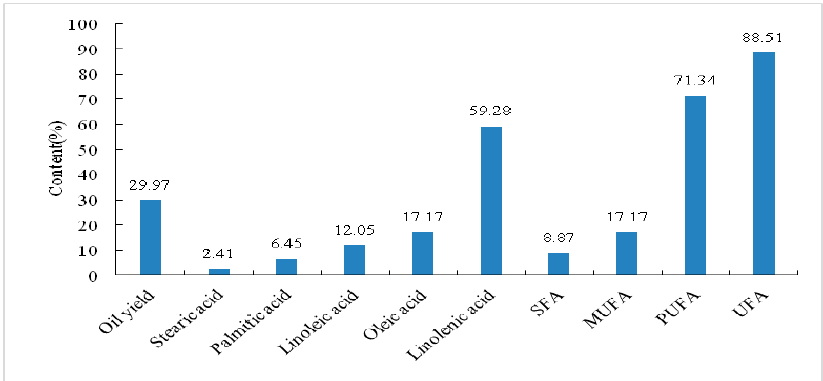
Figure 1. Average oil and fatty acids content of E. ulmoides seeds among 12 populations. SFA: saturated fatty acids; MUFA: monounsaturated fatty acid; PUFA: polyunsaturated fatty acid; UFA: unsaturated fatty